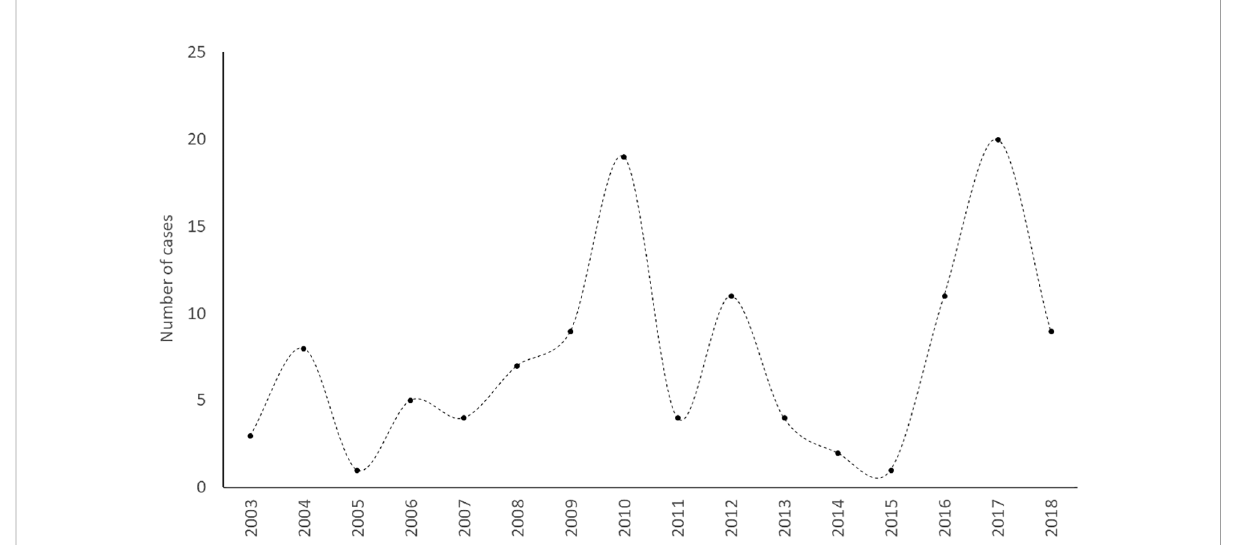
FIGURE 2 Number of recorded cases (N = 118) of tiger attacks on humans across years from 2003 to